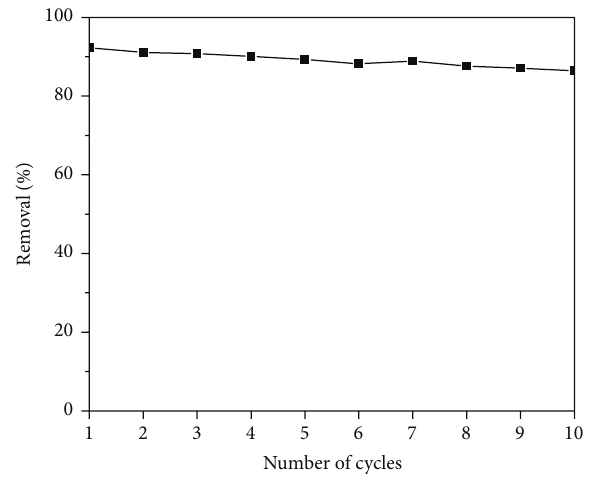
Figure 8: Reusability of modified red mud. Experimental condi- tions: 5 × 10 −5 mol/L MO, 0.7 g/L modified red mud, and irradiation time of 50min.